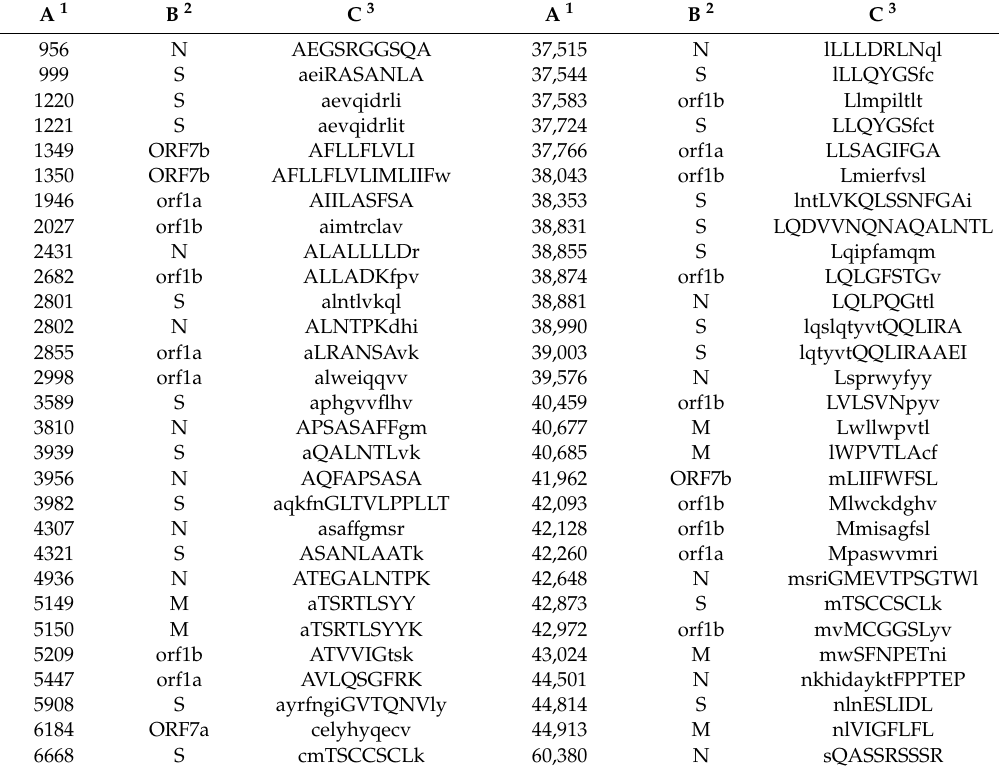
Table 2. SARS-CoV-2 epitopes with sequences shared with human proteins marked in capital